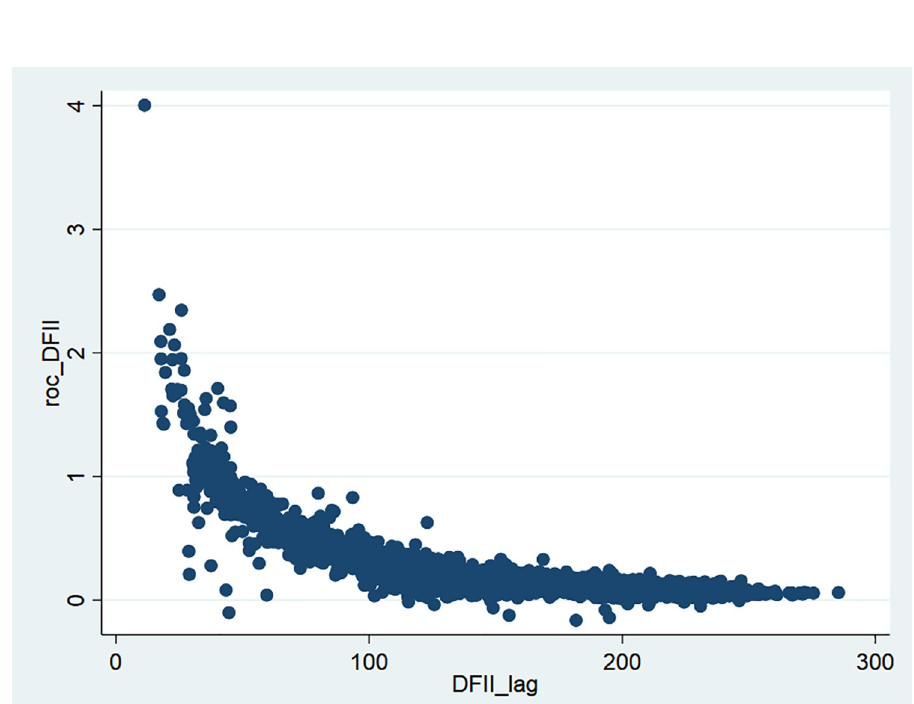
Fig 2. The rate of change of city-level DFII in China from 2011 to 2018.